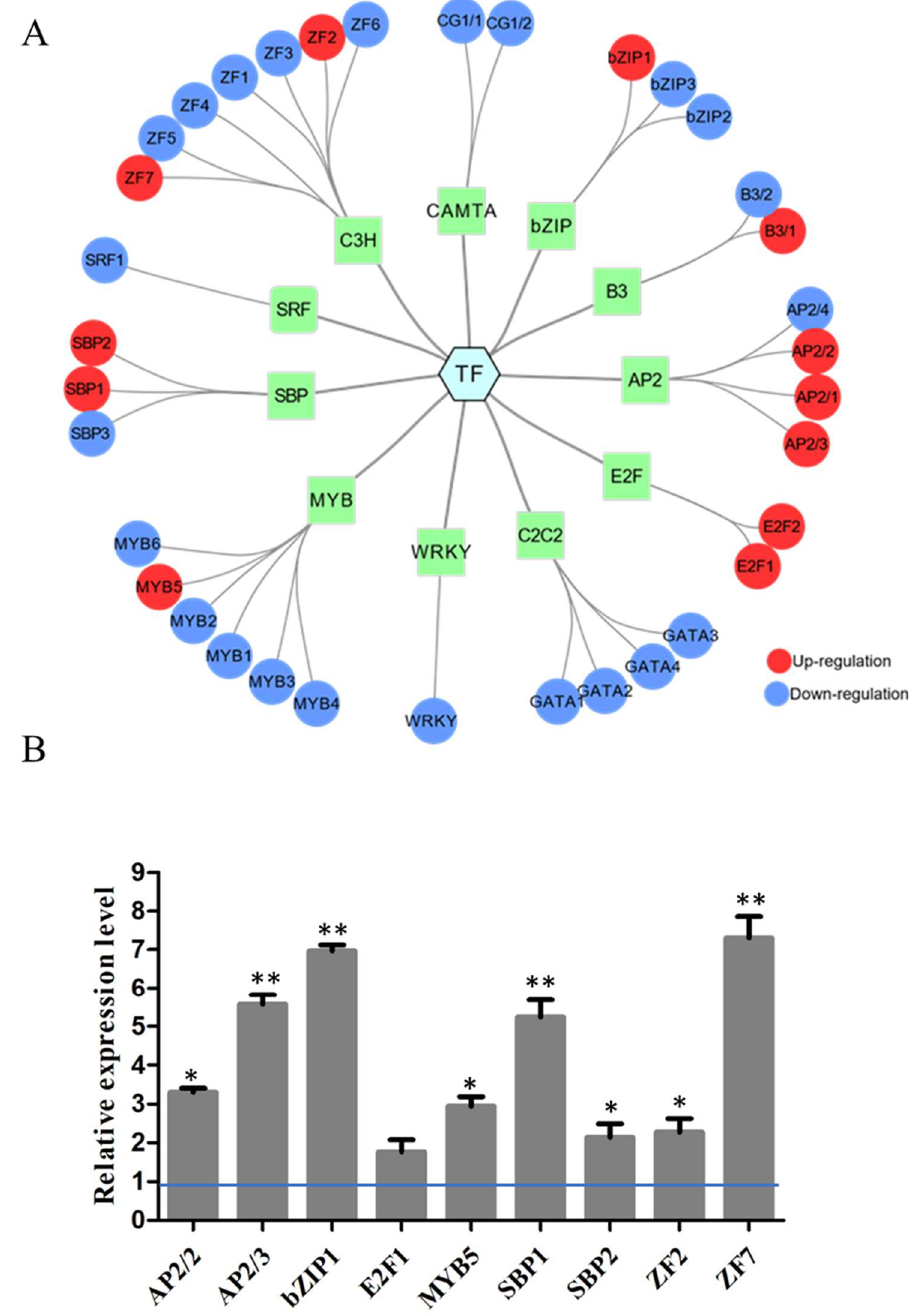
Figure 1. Analysis the expression of transcription factors of Chlorella sp. BLD under alkali conditions. ( A ) RNA-seq analysis the regulation of transcription factors (TFs) expression of Chlorella sp. BLD at pH 10 compared to pH 7.5. The results of the network analysis including TFs were analyzed and visualized using CYTOSCAPE. The red nodes indicate upregulation, and the blue nodes indicate downregulation. ( B ) Validation of the RNA-seq results of transcription factors (TFs) in upregulated by q-PCR. * indicates p -value < 0.05, ** indicates p -value < 0.01.